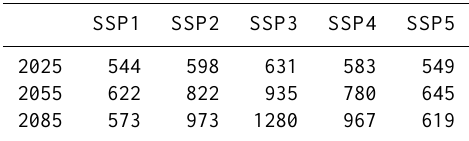
Table 11. Total global withdrawal-based potential municipal water demand (km 3 yr − 1 )